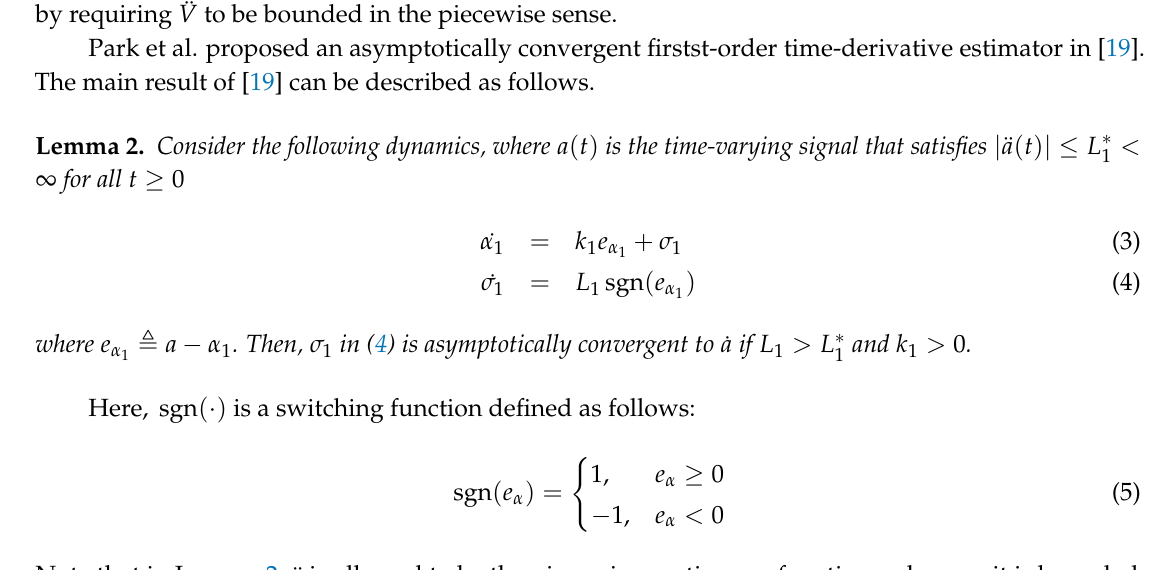
( t ) (solid line) and e α 1